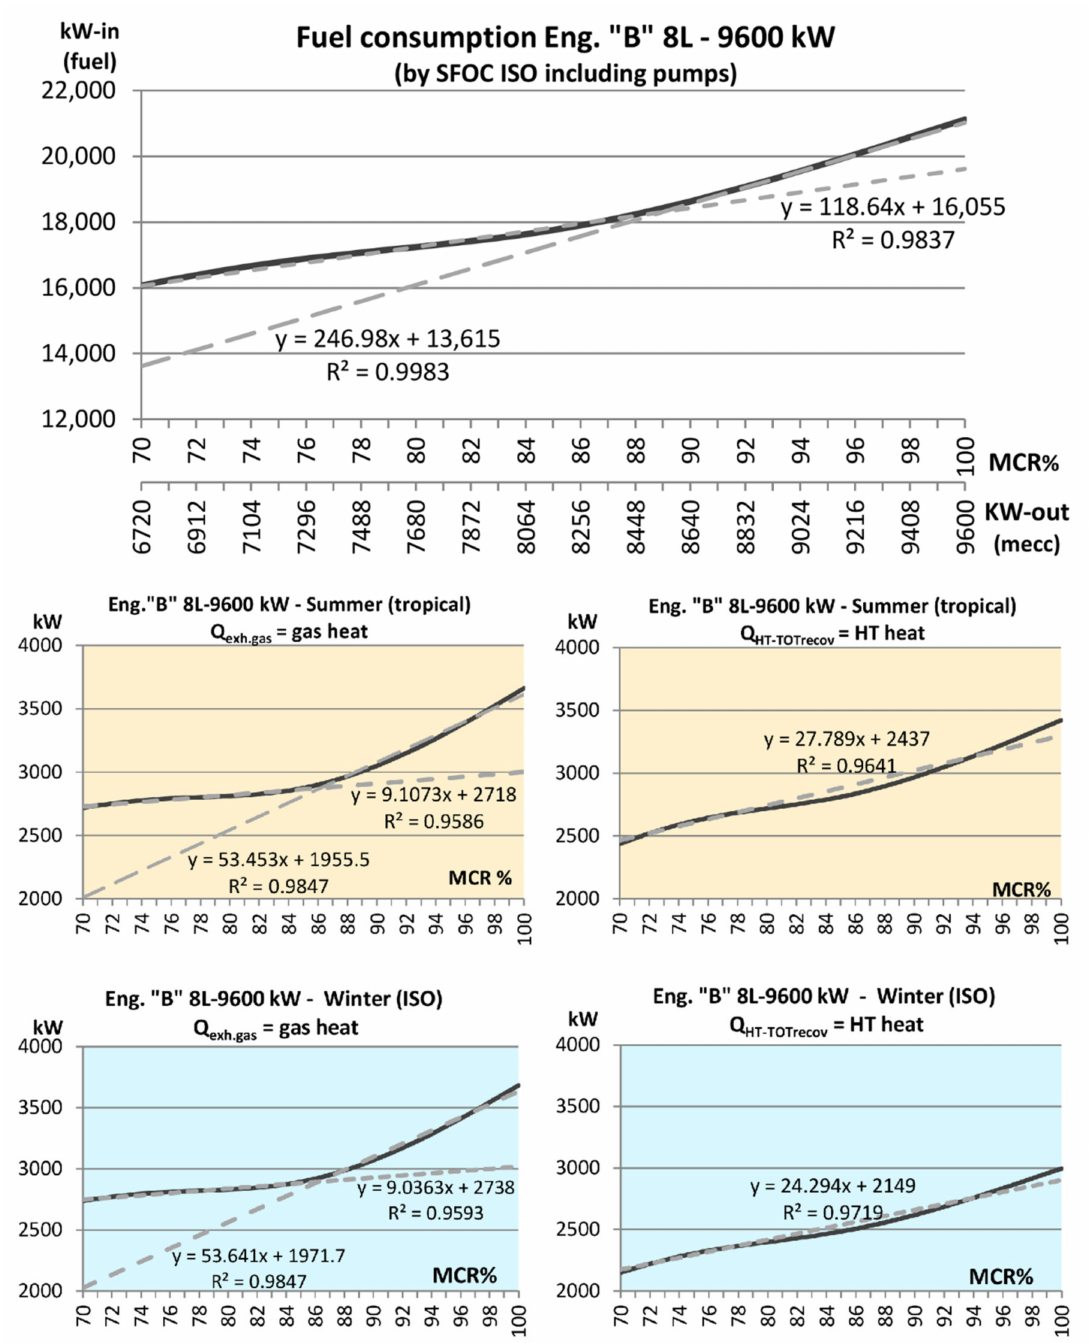
Figure 7. Operating curves of the ICE 8L, with the linearized